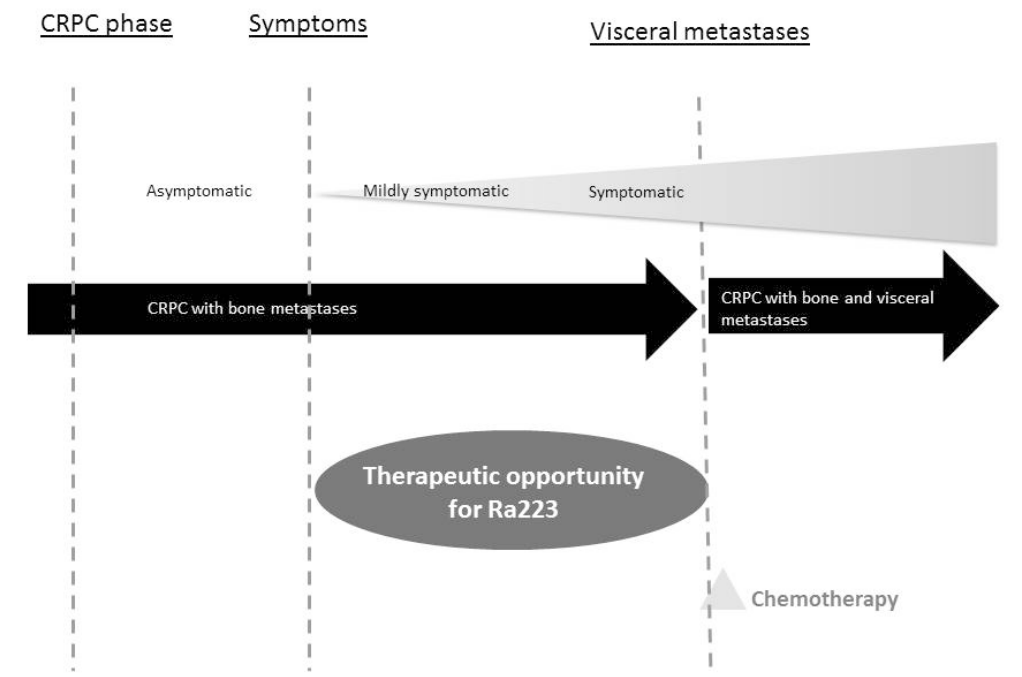
Figure 2. Establishing the right therapeutic collocation of available medications is crucial to prolonging the survival of patients affected by metastatic prostate cancer. Radium-223 should be administered in the early stages of the disease: pivotal studies reported that patients with a less advanced disease in terms ofECOG- Performance Status (ECOG-PS), hemoglobin, pain, PSA, ALP, lactate dehydrogenase (LDH), and albumin were more likely to receive 5–6 radium-223 injections. Same studies correlated the number of radium-223 injections with survival benefit. Finally, a pre-specified analysis of Α radin in SYMPtomatic Prostate CAncer (ALSYMPCA) revealed that patients who received a previous docetaxel therapy increased their risk of experiencing hematologic adverse events.